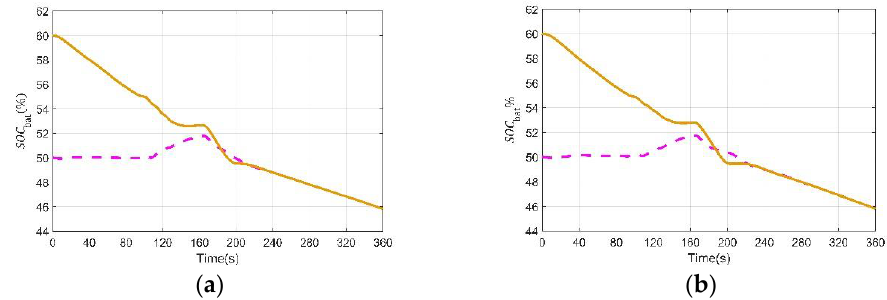
Figure 20. Comparison of the change in the SOC value of the lithium battery: ( a ) fixed filter time constant; ( b ) variable filter time constant.